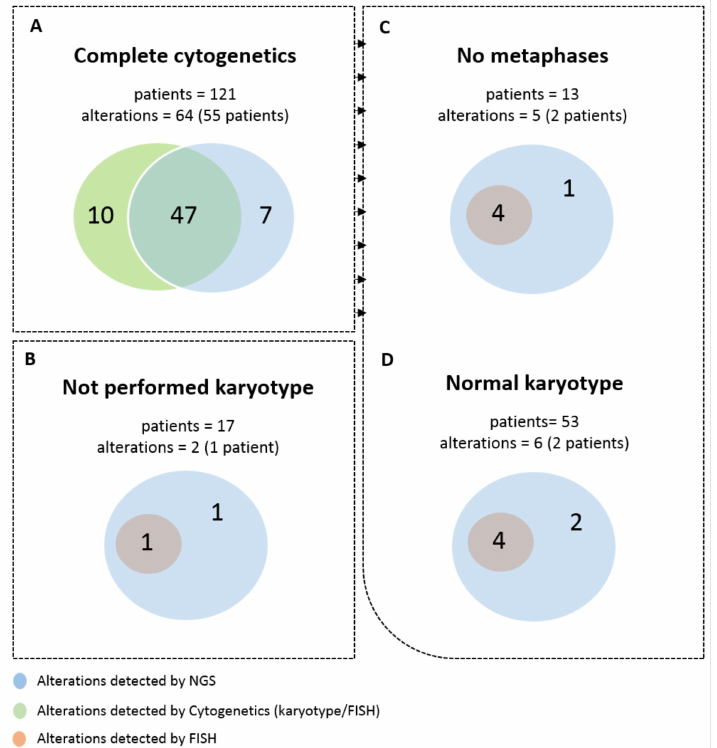
Figure 1. Total number of frequent alterations observed by both NGS panel and cytogenetics. ( A ) All patients with complete cytogenetic analysis performed. ( B ) Patients without karyotype study. ( C ) Patients in which the cytogenetic analysis did not render metaphases to analyze. ( D ) and patients with normal